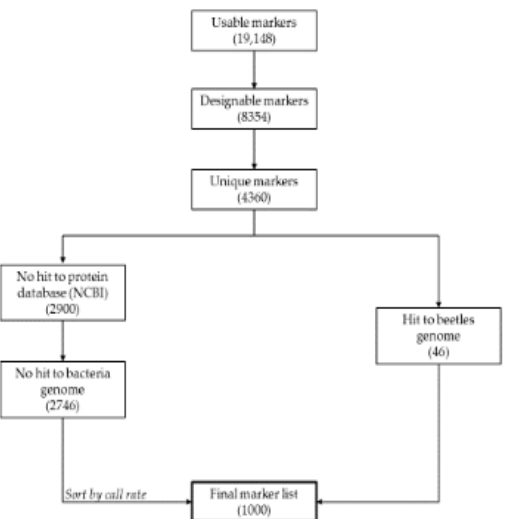
Figure 1. A flowchart of SNP filtration steps. The number in brackets at each filtration step represents the number of markers.